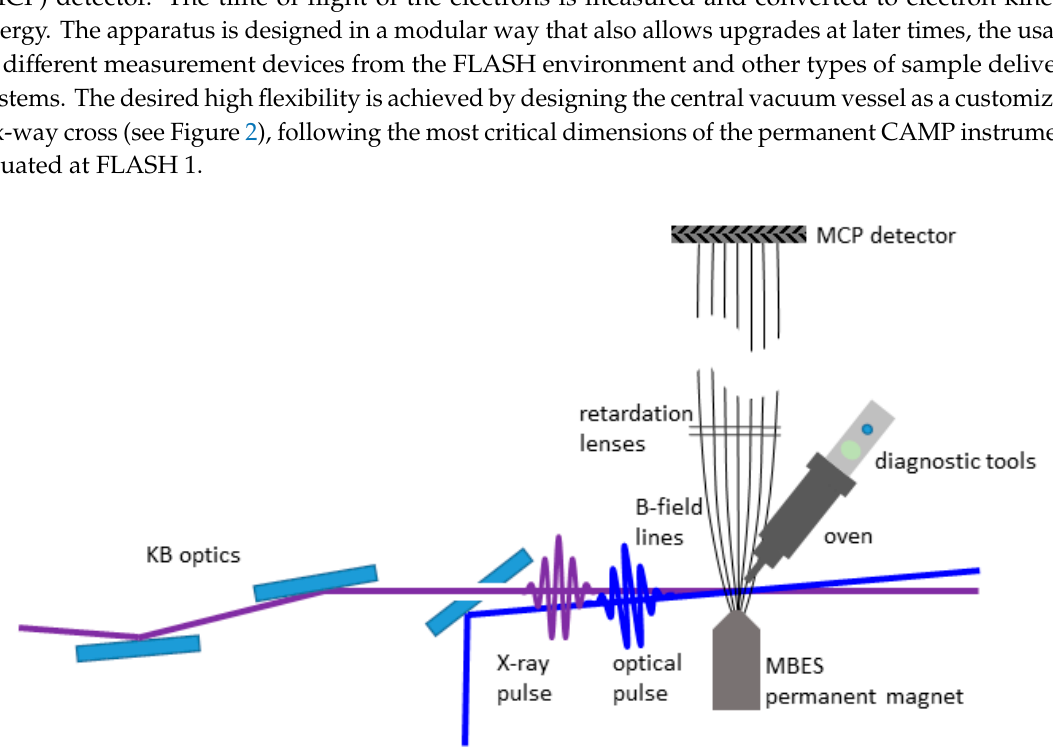
Figure 1. Diagrammatic representation of the URSA-PQ (German for ‘Ultraschnelle Röntgenspektroskopie zur Abfrage der Photoenergiekonversion an Quantensystemen’, Engl. ‘ultrafast X-ray spectroscopy for probing photoenergy conversion in quantum systems’) instrument with its functionalities. The molecular sample is evaporated and guided into the interaction region by a capillary oven. An optical laser pulse excites the sample before a delayed X-ray pulse from the FLASH FEL, focused by a Kirkpatrick-Baez (KB) mirror set, probes the excited molecular ensemble. Photo- and Auger-electrons created by the light-matter interaction are guided by the magnetic field of the magnetic bottle electron spectrometer (MBES) towards a detector. The diagnostic tools for spatial and time-overlap can we driven into the interaction region.